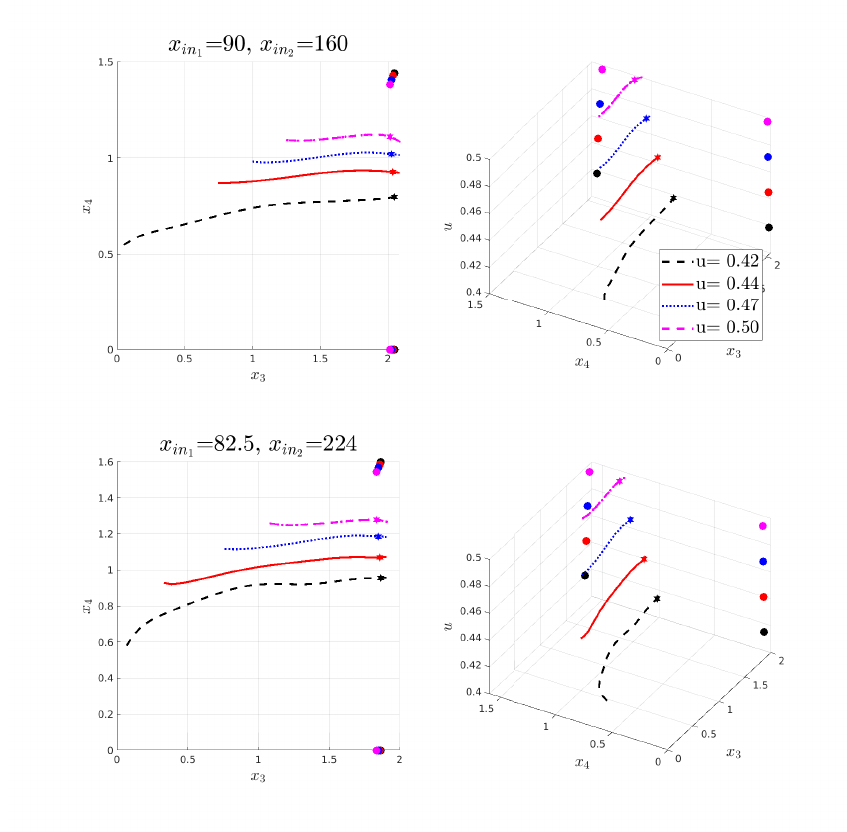
Figure 10: Intersection of the stable manifold, different realizations with different u , and constant concentrations at the